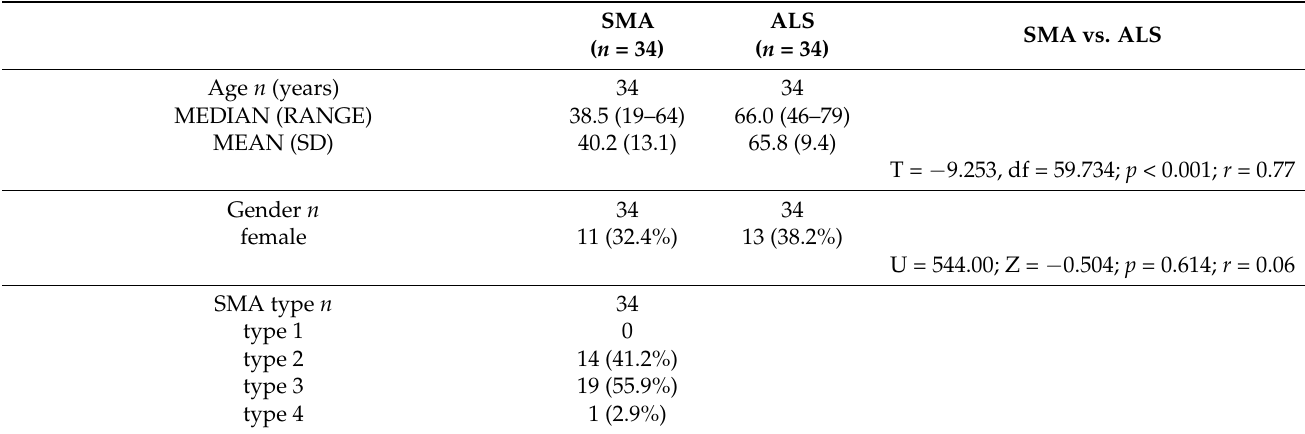
Table 1. Clinical characterization of spinal muscular atrophy (SMA) and amyotrophic lateral sclerosis (ALS) patients. This table shows disease factors with a possible influence on cognitive function. Effect sizes of r = 0.10, r = 0.30, and r = 0.50 served as thresholds for small, medium and large effects [30], respectively. Abbreviations: SMA, Spinal Muscular Atrophy; ALS, Amyotrophic Lateral Sclerosis; ALSFRS-R, Amyotrophic Lateral Sclerosis Functional Rating Scale revised form; SD, standard deviation; n , number; vs.,